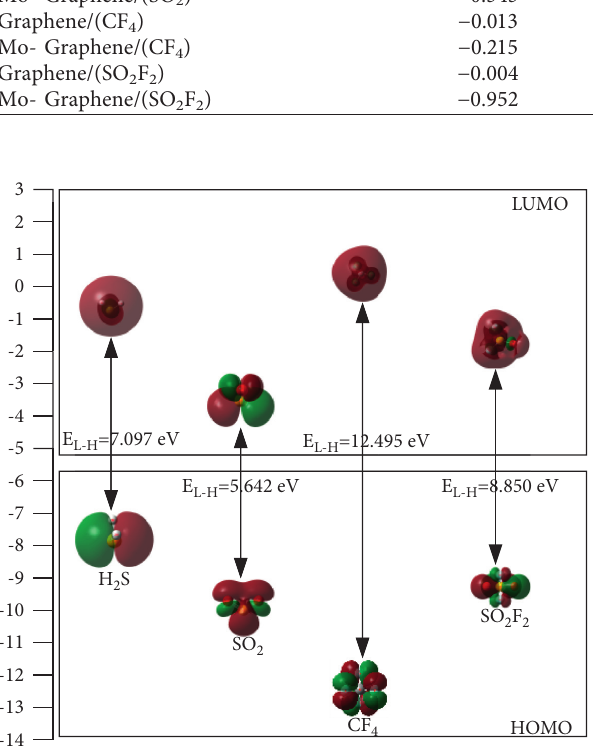
2 S, SO 2 , CF 4 , and SO 2 F 2